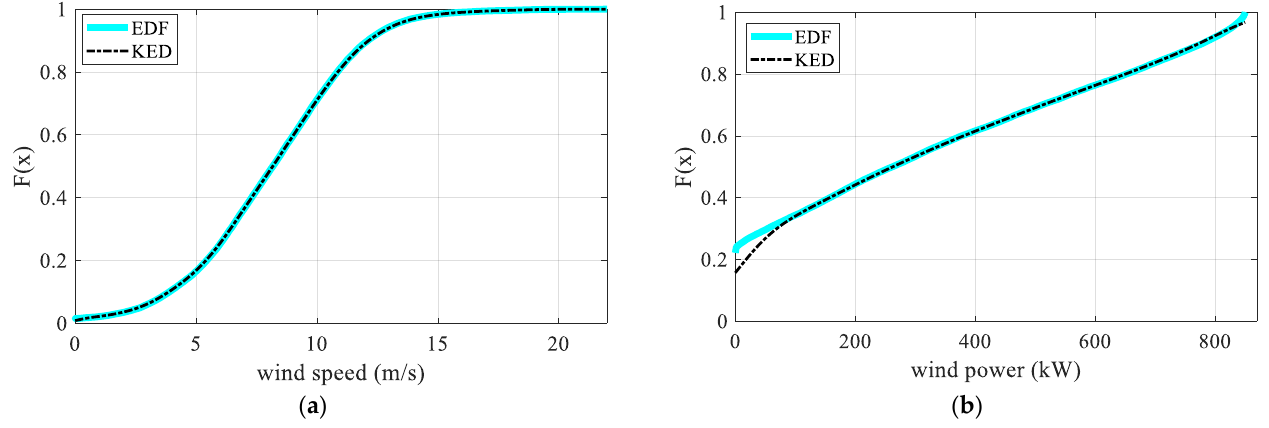
Figure 3. The empirical distribution function and kernel distribution estimation of wind speed and power: ( a ) the empirical distribution function and kernel distribution estimation of wind speed; ( b ) the empirical distribution function and kernel distribution estimation of wind power.